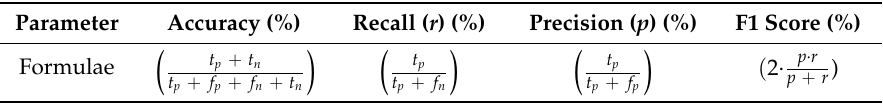
Table 2. Extracted output metrics and their